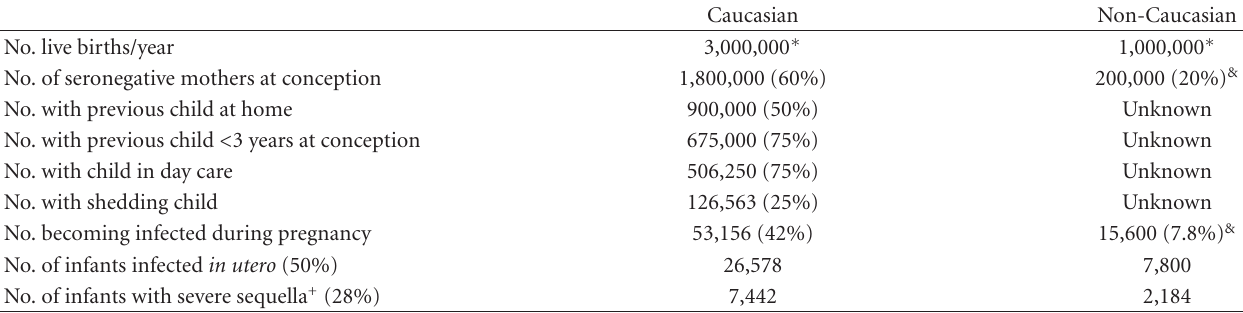
Table 2: Estimated annual impact in the USA of group child care on the rate of congenital CMV infection among multiparous Caucasians compared to multiparous non-Caucasians without group child